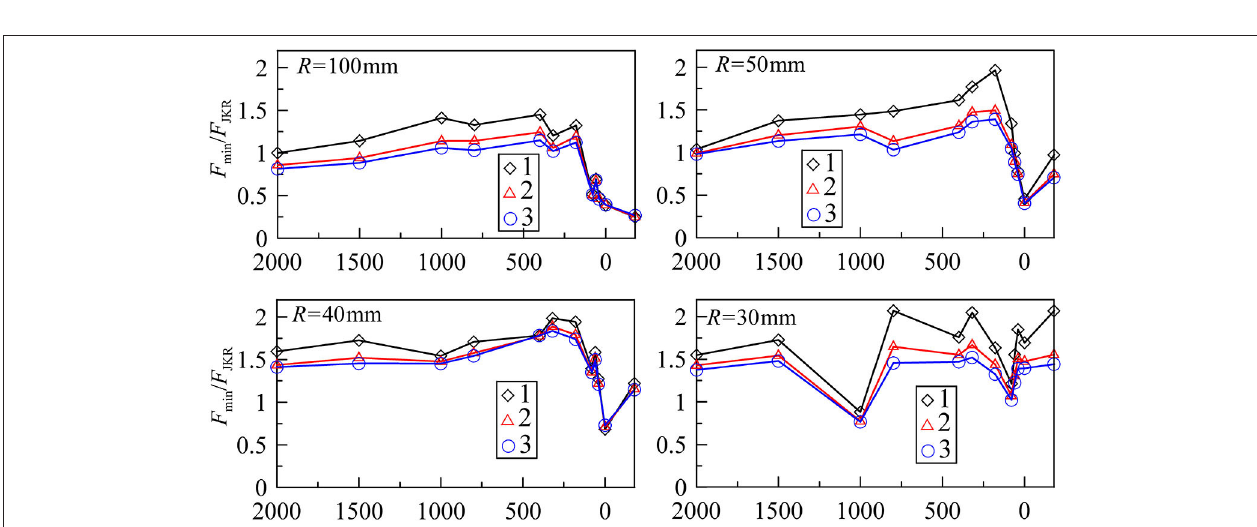
FIGURE 6 | Dependencies of adhesive strength measured in experiments vs. grit number of sandpaper for indenters with radius R = 100, 50, 40, and 30mm. The symbols with numbers 1, 2, and 3 in the figure are first (diamonds), second (triangles), and third (circles) cycles of indentation.